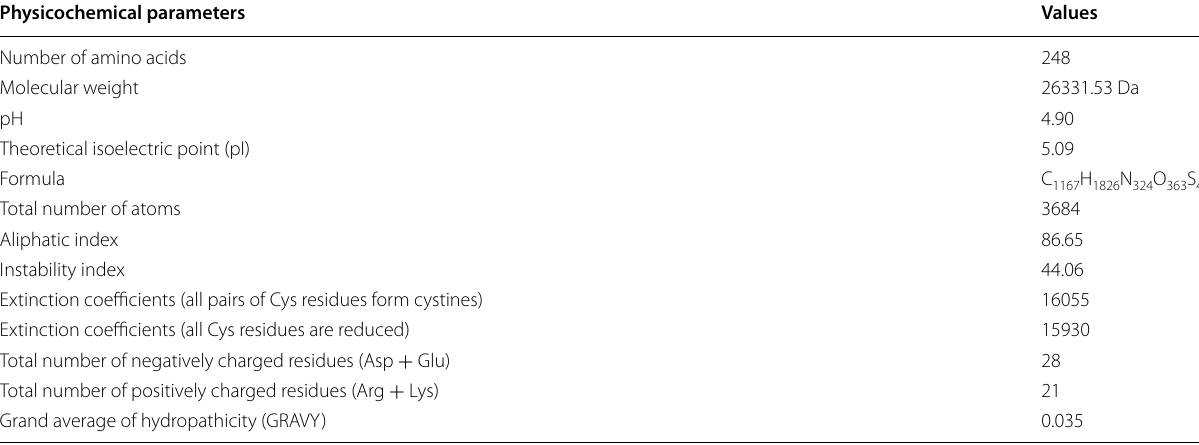
Table 1 Physical and chemical characteristics of NHP1 protein predicted using EXPASY ProtParam server Physicochemical